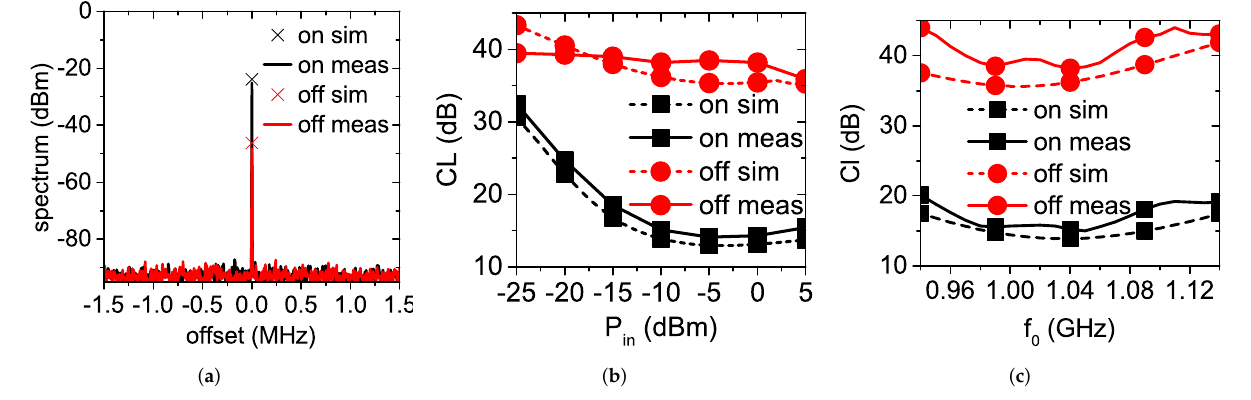
Figure 6. Doubler performance in static conditions. ( a ) output spectrum when the MOSFET is on and off ( f 0 = 1.04 GHz and P in = − 10 dBm). Conversion loss of the doubler when the MOSFET is on and off ( b ) versus P in ( f 0 = 1.04 GHz) and ( c ) versus f 0 ( P in = − 10 dBm).